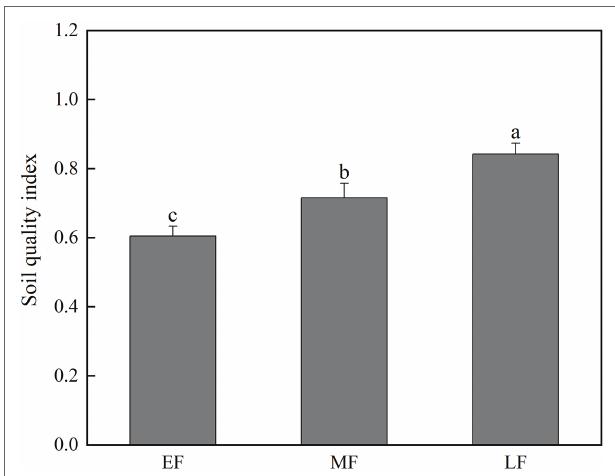
FIGURE 7 | The 0–100 cm soil quality index under different forests types. Values are the means ± SE ( n = 6). The lowercase letters above the column represent the statistically significant differences between different stand types (Duncan’s tests, p < 0.05). EF, broadleaf–conifer mixed forest; MF, broad- leaved forest; LF, old-growth